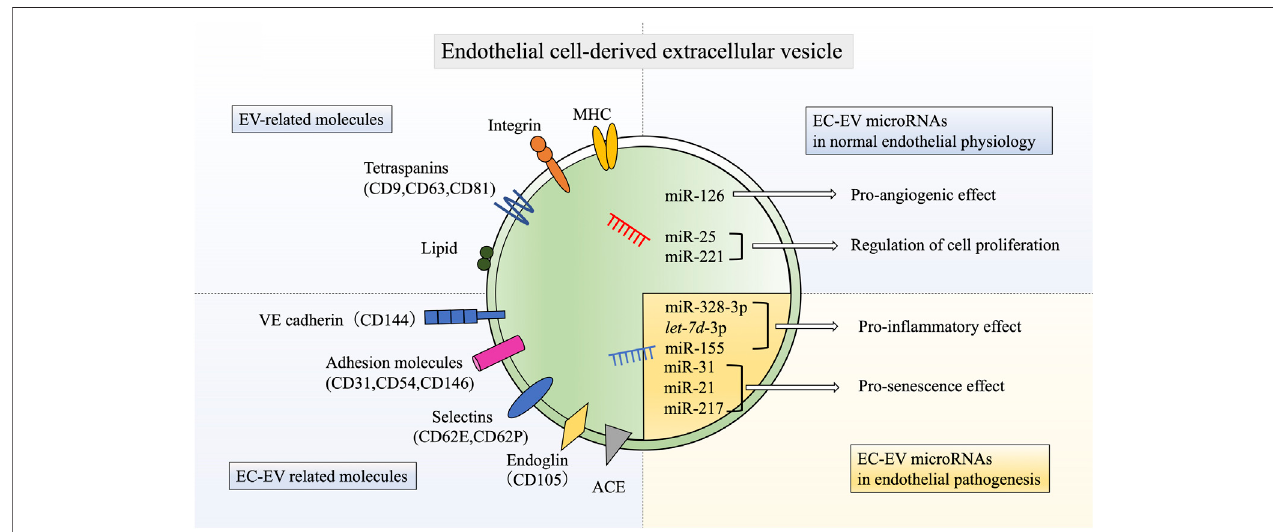
FIGURE 1 | Schematic molecular components of endothelial cell-derived extracellular vesicles. EC-EVs have various EV-related molecules, such as tetraspanins, MHC,integrins, and lipids. EC-EVsalso have uniqueendothelialmarkers, including VE-cadherin, E-selectin, P-selectin,PECAM, ICAM-1, MCAM, endoglin, and ACE. In addition, EC-EVs also contain various miRNAs that have biological functions in both normal endothelial physiology and pathogenesis. EC: endothelial cell, EV: extracellular vesicle, miR: microRNA, CD144: vascular endothelial (VE)-cadherin, CD31: platelet-endothelium cell adhesion molecule (PECAM), CD54: intercellular adhesion molecule 1(ICAM-1), CD146: melanoma cell adhesion molecule (MCAM), CD62E: E-selectin, CD62P: P-selectin, ACE: angiotensin converting enzyme, MHC: major histocompatibility